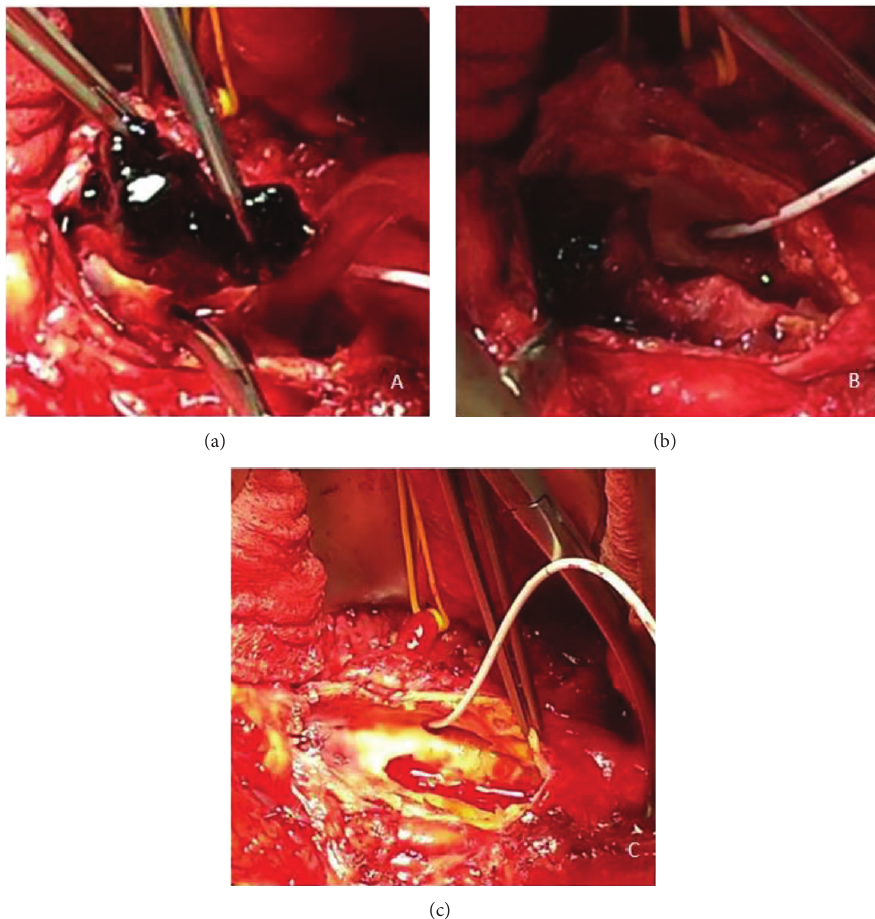
Figure 3: Complete removal of fresh thrombus at the suprarenal aorta level after supraceliac clamping. The yellow vessel loop indicates the left renal artery. The white catheter allowed clamping and perfusing the superior mesenteric artery.